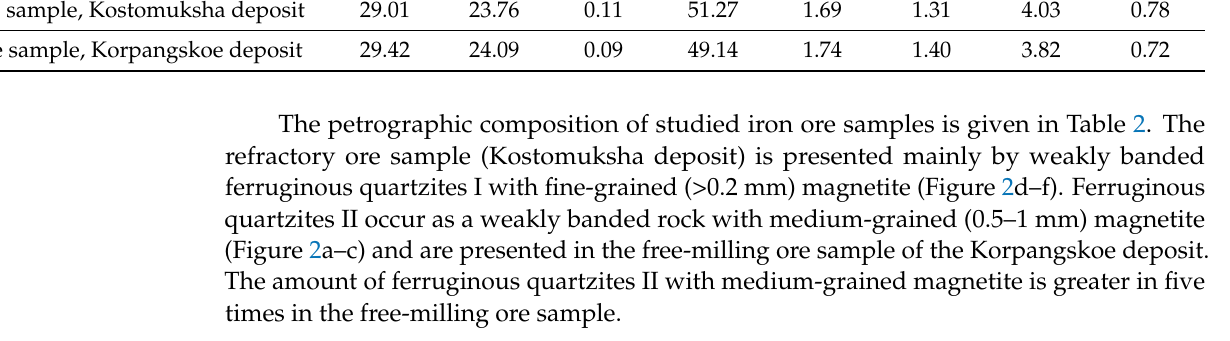
Table 2. Petrographic composition of studied iron ore